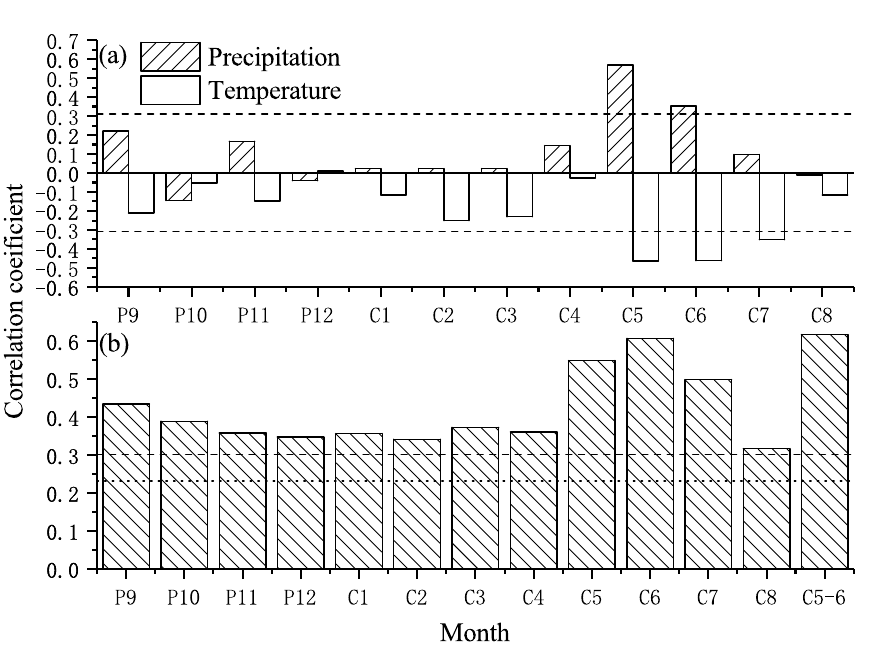
Figure 2. Correlations of GS with ( a ) monthly total precipitation and monthly mean temperature data for 1951–2018; ( b ) scPDSI for 1943–2014. The dashed lines indicate the corresponding 99% confidence